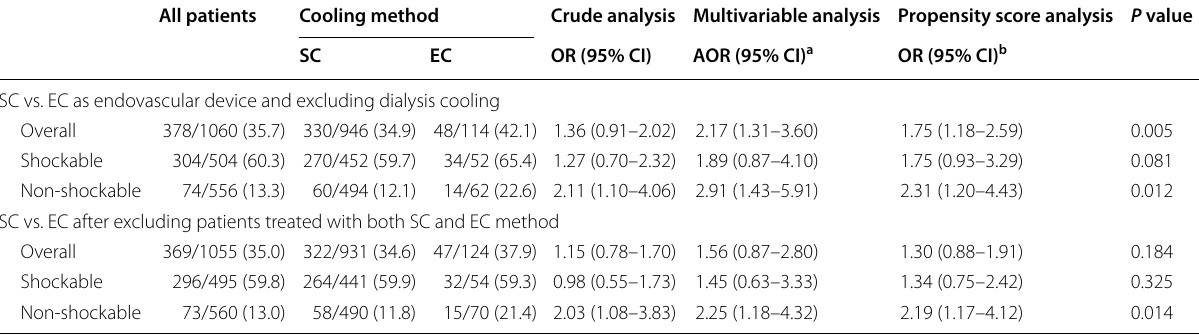
Values are expressed numbers (percentages) unless indicated otherwise TTM target temperature management, SC surface cooling, EC endovascular cooling, OR odds ratio, AOR adjusted odds ratio, CI confidence interval a Shown is the adjusted odds ratio from the multivariable random effects logistic regression analysis with hospital treated as a random effect, with stratification according to age, sex, cause of arrest, bystander witness, bystander CPR status, use of public-access AEDs, prehospital adrenaline administration, prehospital advanced airway management, EMS response time, target temperature, TTM induction time b Shown is the odds ratio from the univariable logistic regression analysis with inverse probability weighting according to the propensity